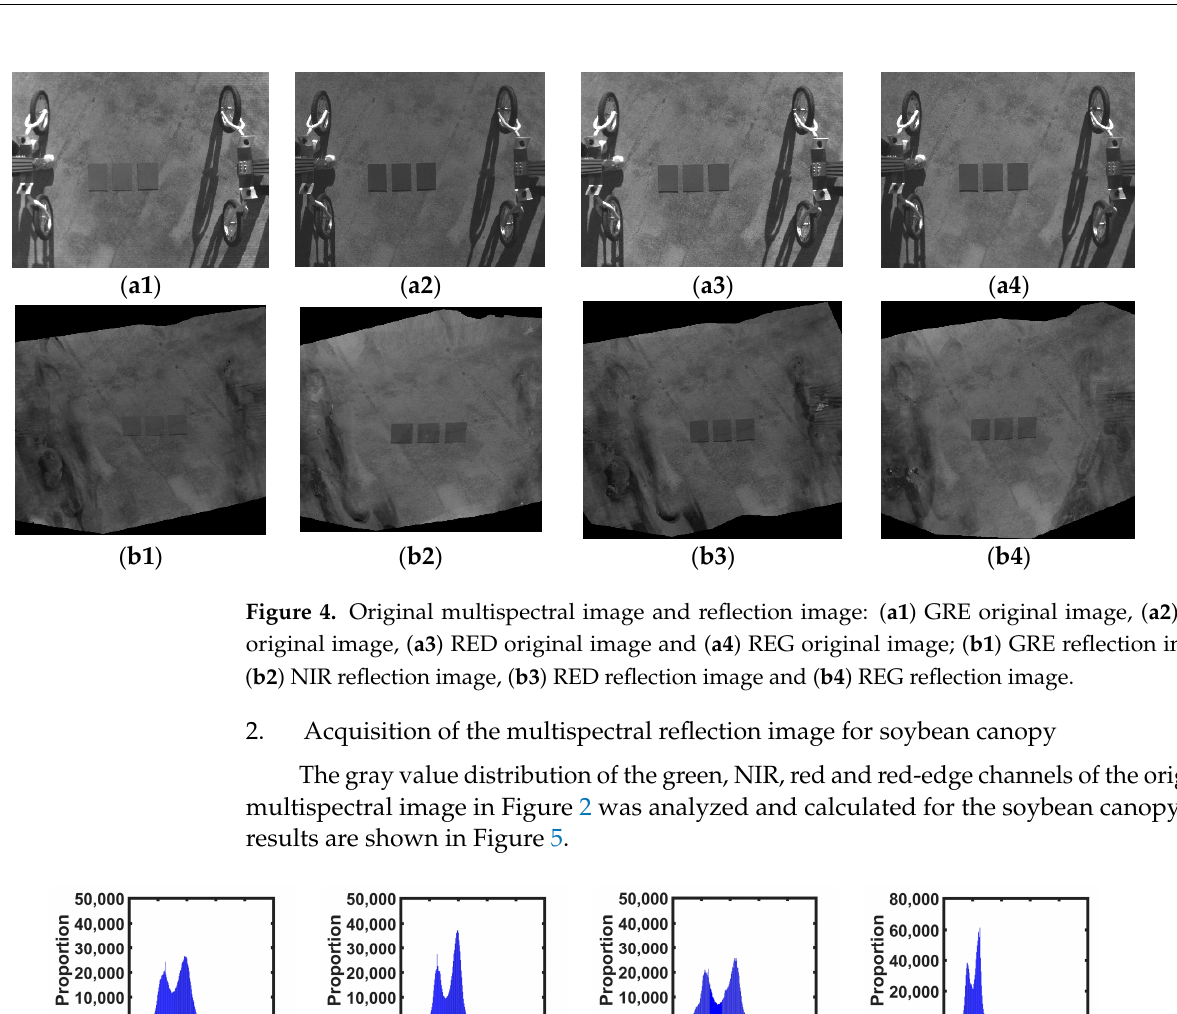
Table 1. Calibration equation for the multispectral camera.